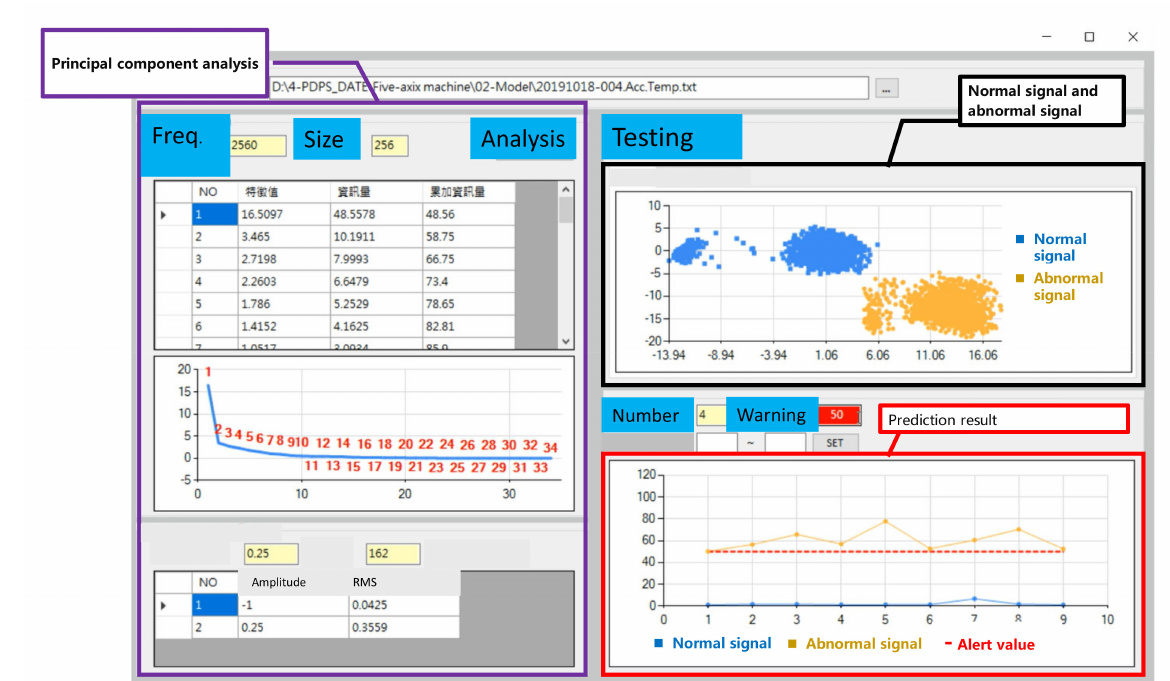
Figure 7. Principal component analysis modeling and